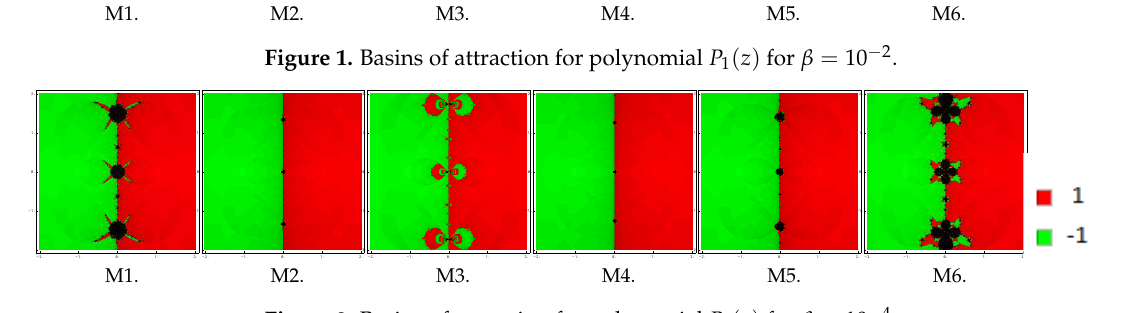
Figure 2. Basins of attraction for polynomial P 1 ( z ) for β = 10 − 4 .